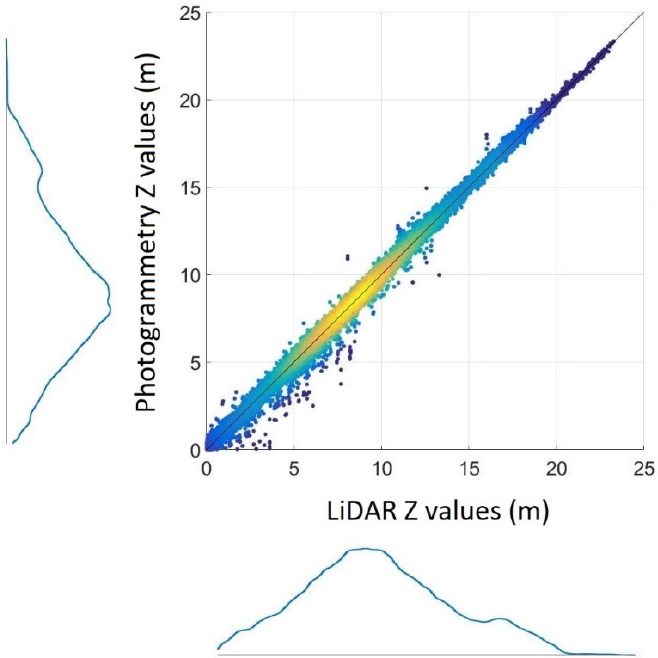
Figure 13. Scatterplot of Z values for photogrammetric and LiDAR point clouds.